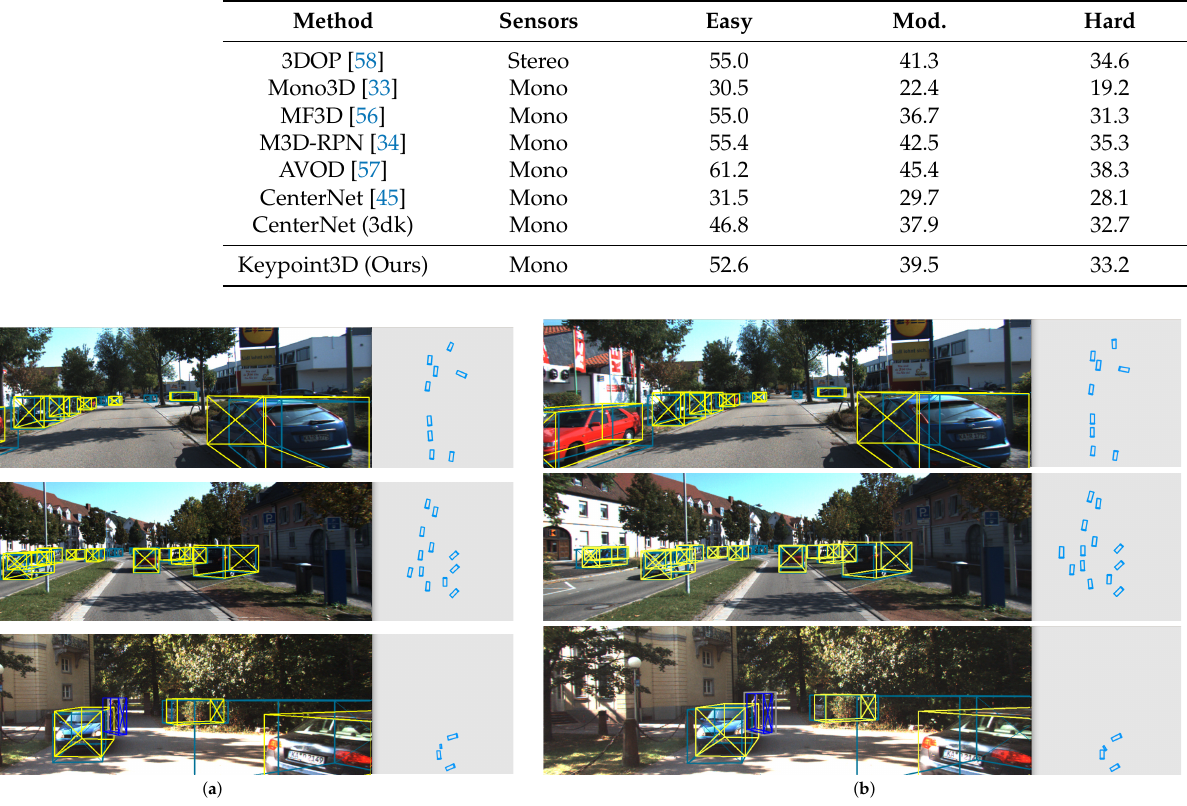
Figure 9. Qualitative comparisons of the detection performance in 3D and BEV on the KITTI val set. ( a ) Baseline work (CenterNet). ( b ) The proposed method (Keypoint3D). Ground truth labels present cars, pedestrians, and cyclists with yellow, red and blue boxes, respectively. The predicted results present cars, pedestrians, and cyclists with pale blue, brown, and gray boxes, respectively. The heading direction is represented with a cross mark.